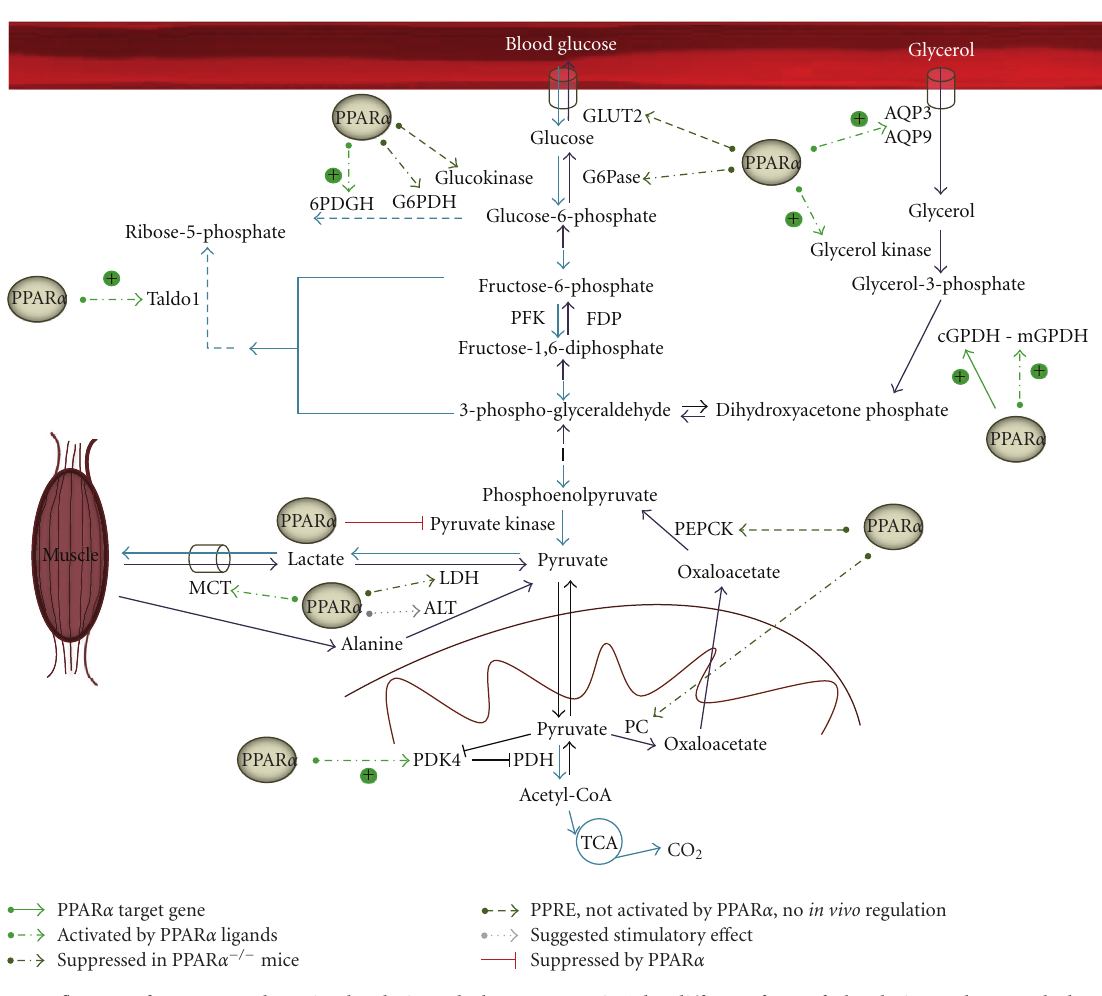
Figure 2: Influence of PPAR α on hepatic glycolysis and gluconeogenesis. The di ff erent fates of glycolytic products and gluconeogenic precursors are depicted, together with the regulatory e ff ects of PPAR α . Blue arrows show breakdown of glucose via glycolysis, PPP and TCA cycle; purple arrows indicate gluconeogenic steps. Genes which were proven to be directly regulated by PPAR α are presented as a full green arrow. Stimulatory e ff ects which were only proven by treatment with PPAR α ligands are shown as a dashed bright green arrow. An e ff ect that was only observed in PPAR α − / − mice is depicted as a dark green dashed arrow. Genes in which a PPRE was identified, but no in vivo activation by PPAR α was observed are presented with a dark green dotted arrow. Genes which were only suggested to be stimulated by PPAR α are indicated with a grey dotted arrow. A suppressive e ff ect of PPAR α is shown with a red mark. 6PDGH: 6-phosphogluconate dehydrogenase; ALT: alanine transaminase; AQP: aquaporin; FDP: fructose-di-phosphatase; G6Pase: glucose-6-phosphatase; G6PDH: glucose-6-phosphate dehydrogenase; GLUT2: glucose transporter 2; cGPDH: cytosolic glycerol 3-phosphate dehydrogenase; MCT: monocarboxylate